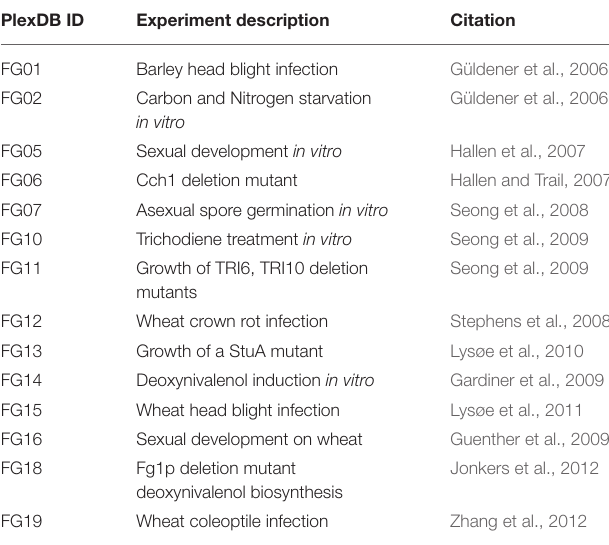
TABLE 1 | F. graminearum microarray transcriptomics